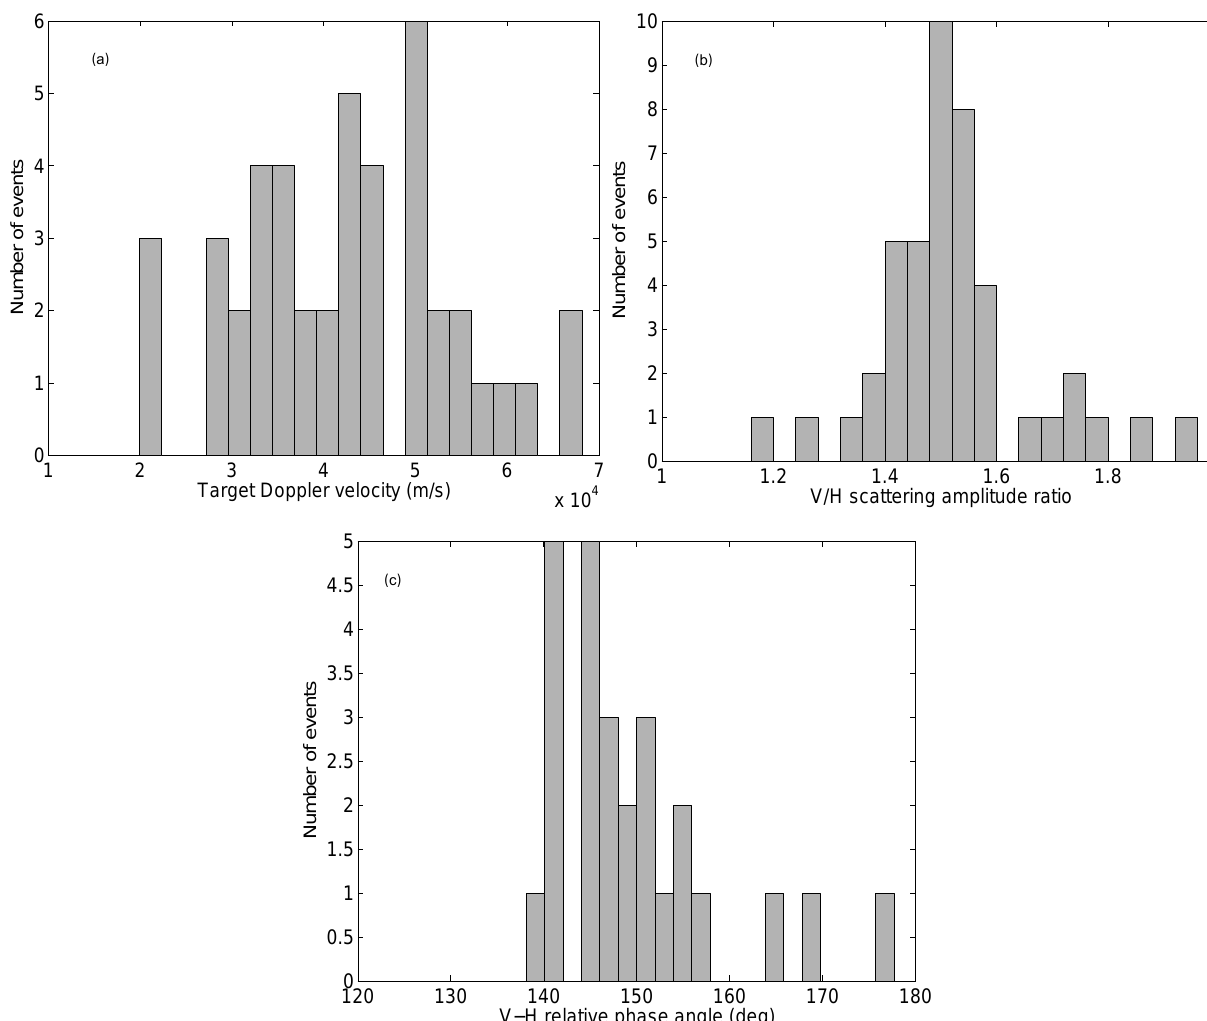
Fig. 3. Histograms showing (a) target Doppler velocities, (b) V/H scattering amplitude ratios and (c) V-H relative phase angles. (a) and (b) show results from all 44 resolved events, while (c) shows only the 26 events from 7 October 2009.